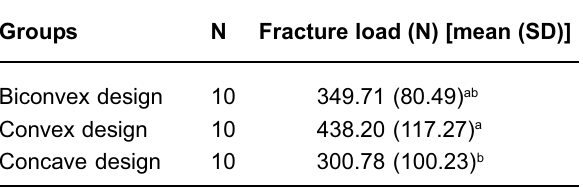
TABLE 1- Summary of the results obtained for fracture resistance